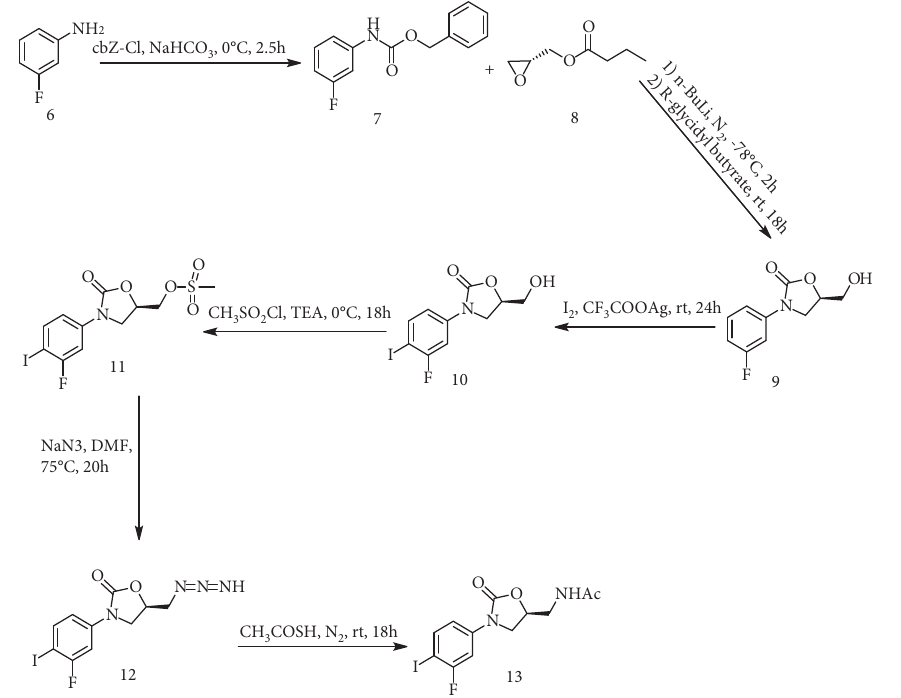
Scheme 11: Pathways of intermediate 13